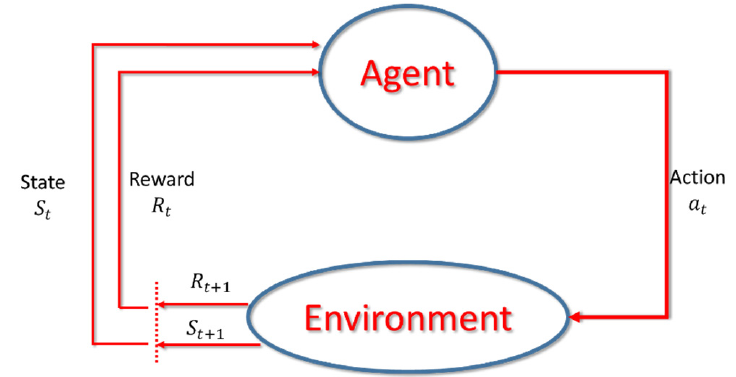
Figure 2. Diagram of reinforcement learning.